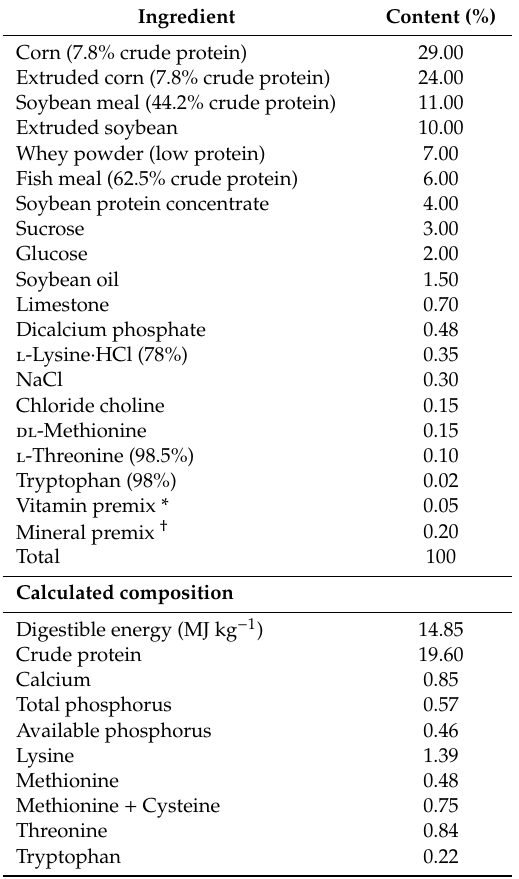
Table 1. Ingredients and nutrient composition of the basal